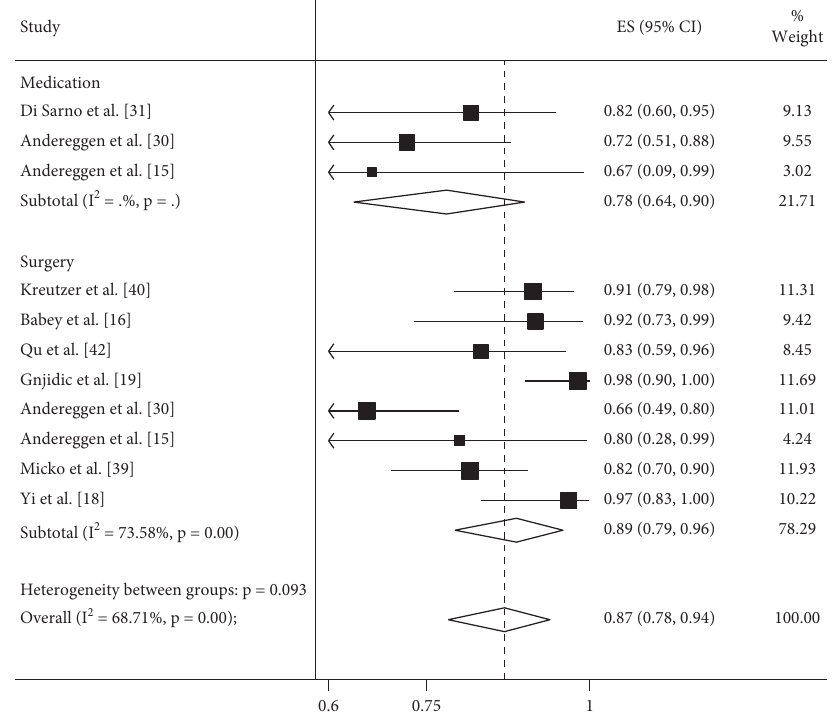
Figure 2: Meta-analysis of remission rates comparing surgery and medical treatment in microprolactinomas at ≤ 3 months of follow-up. The remission rate was achieved in 89% of patients treated with surgery and 78% of patients treated with DAs ( P � 0 . 092) at ≤ 3 months of